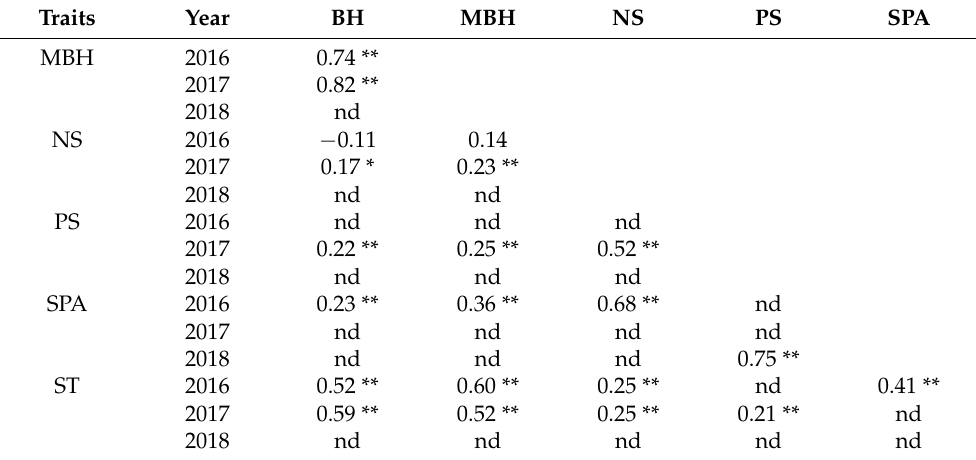
Table 2. Spearman correlation coefficients between morpho-agronomic traits in a F 1 population of garden